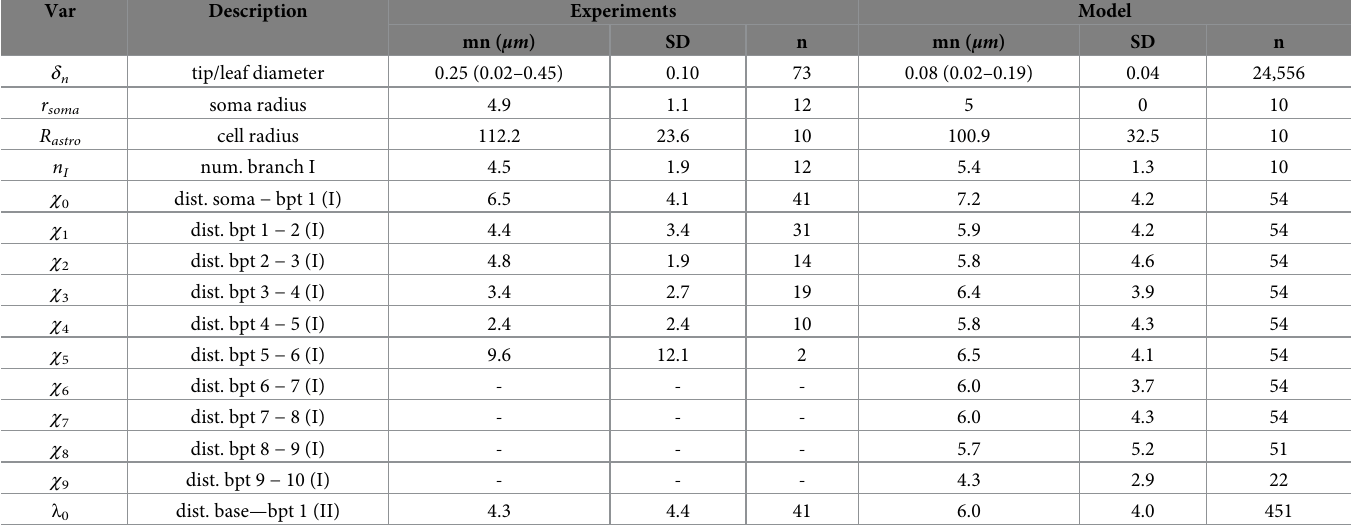
Table 3. List of parameters describing astrocyte morphology in vitro and in silico . Morphological measures were determined experimentally from 3D axial STEM tomography reconstructions ( δ n ) and from biocytin-filled neurons processed with proExM and imaged with 2P-LSM ( r soma , R astro , n I , χ 0 − 9 , λ 0 ). These measures were used to implement the in silico , model representations of astrocytes. Abbreviations: number of primary branches (num. branch I), distance (dist.), branching point (bpt), pri- mary branch (I), secondary branch